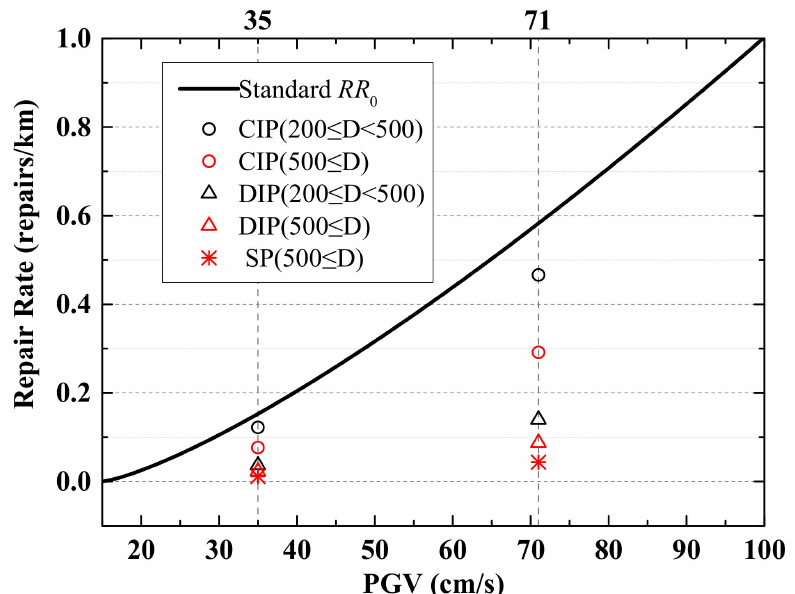
Figure 8. Pipeline repair rates evaluated by the fragility model of JWWA.